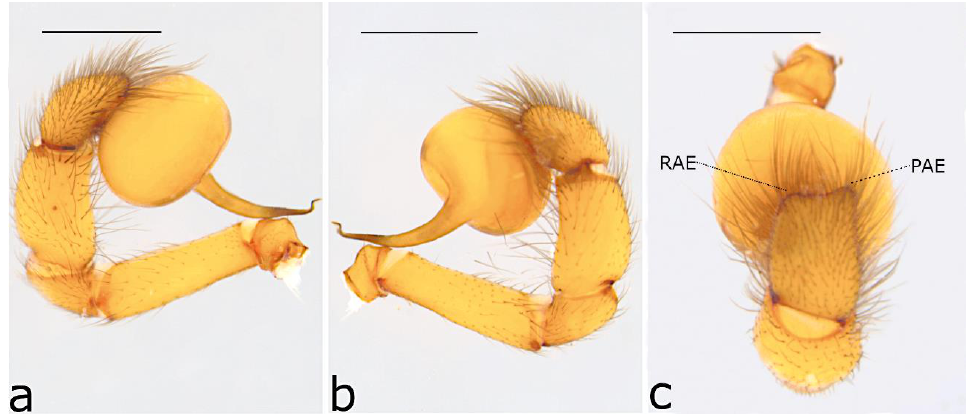
Figure 36. Ariadna diucrura sp. nov. ♂ holotype (SAMA NN31206) from Roxby Downs (SA): ( a ) left